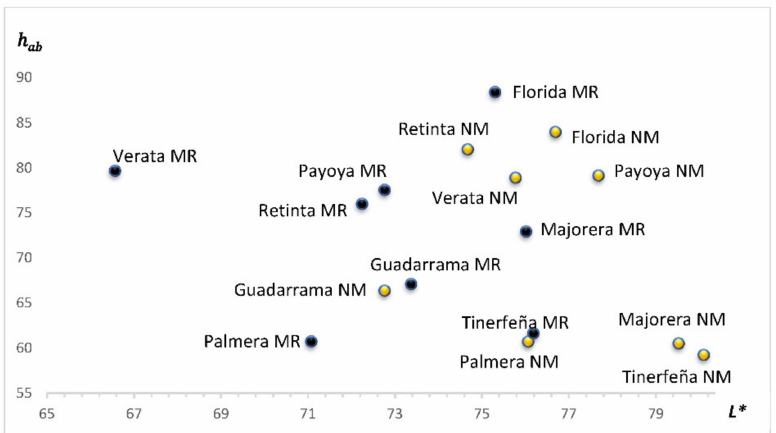
Figure 1. L* versus H ab colour parameters of the kidney fat of kids reared with milk replacer (MR) or natural milk from their dams